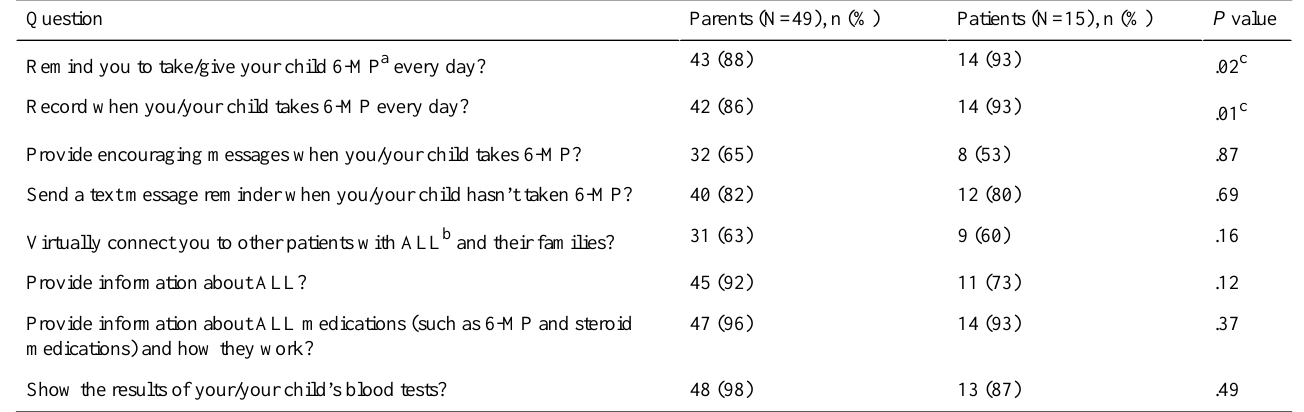
Table 2. Frequency of participants’reported interest in general mHealth